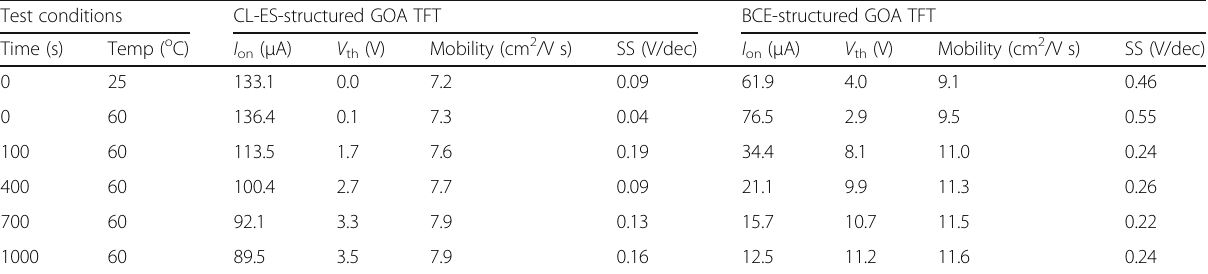
Table 1 I - V transfer characteristics measured during the HCS evaluation of the CL-ES- and the BCE-structured GOA TFTs Test